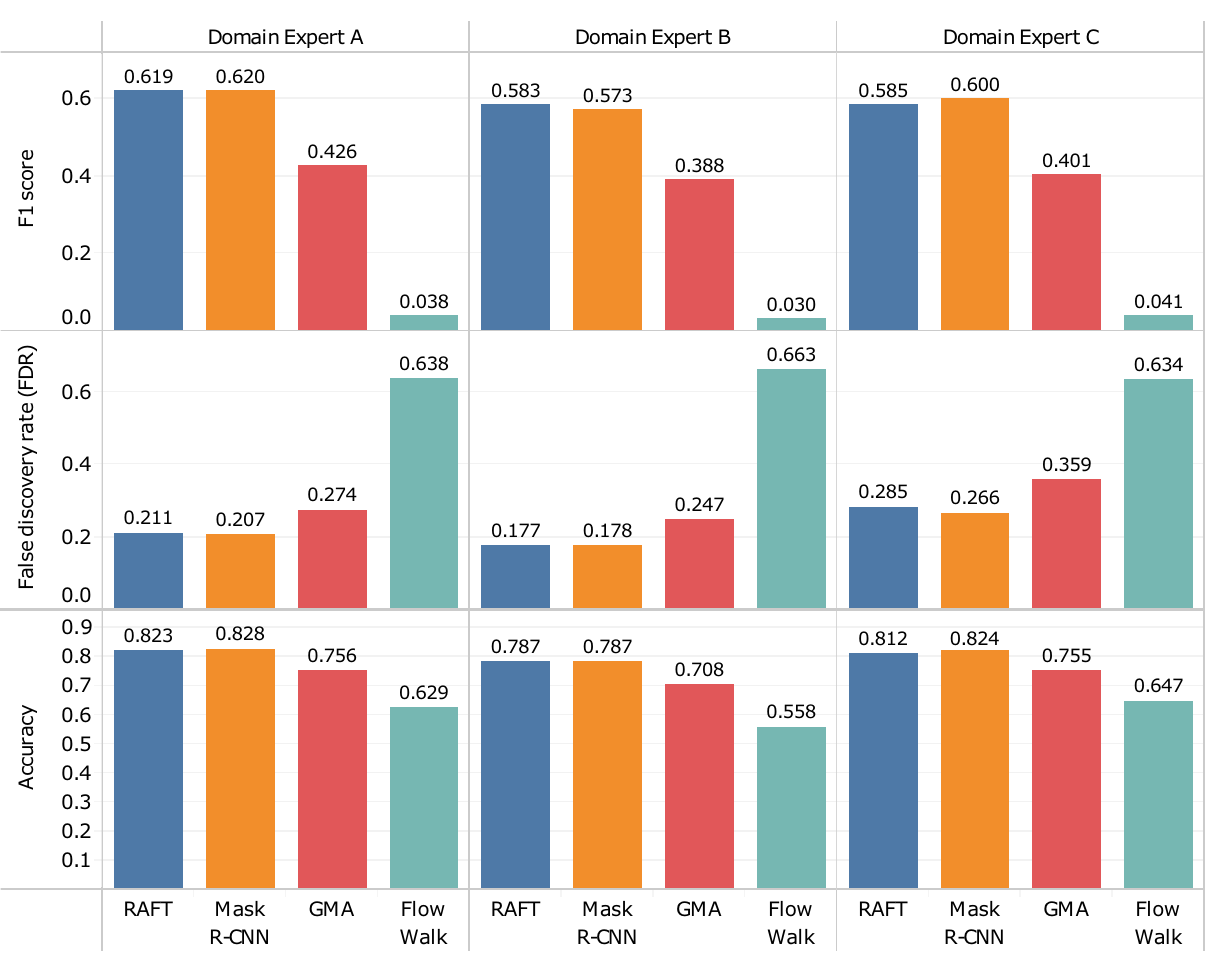
Figure 5. F1 score, false discovery rate (FDR), and accuracy of the four methods (RAFT, Mask R-CNN, GMA, and Flow Walk) on the real GPI data with 3000 frames hand-labeled by three domain experts ( A – C ). Metrics shown are the average per-frame scores (i.e., the average across the